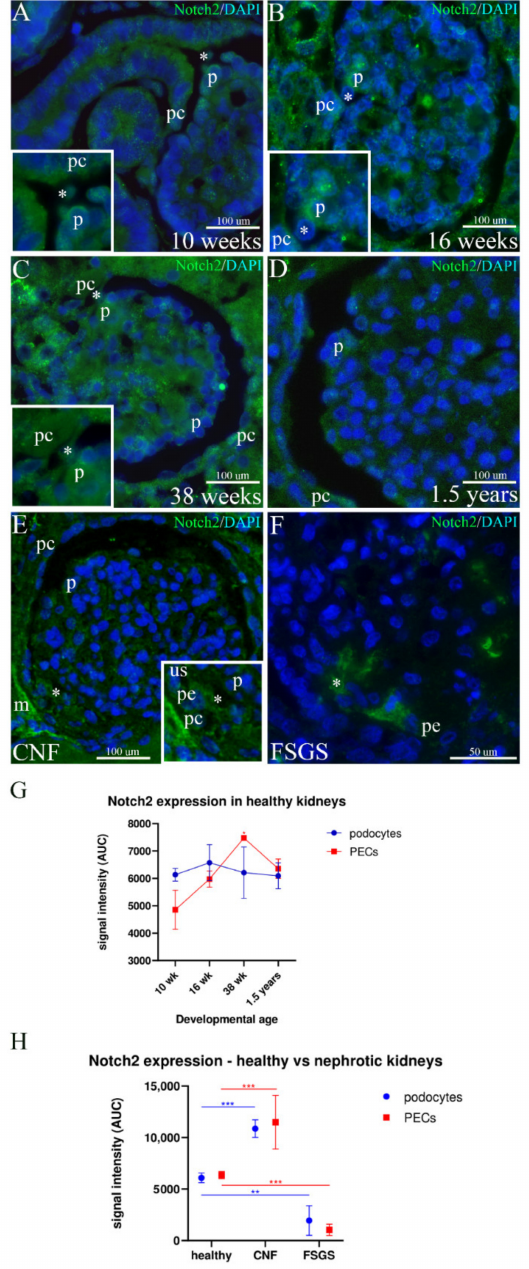
Figure 4. Expression of Notch2 in the developing podocytes and PECs in postnatal healthy kidneys and in kidneys affected by CNF and FSGS; mesenchyme (m), podocytes (p), PECs (pc), peripolar cells (pe), urinary space (us). ( A ) 10th developmental week; cells bridging the urinary space are seen (inset, asterisk). ( B ) 16th developmental week; cellular bridges (asterisk) connect podocytes and PECs (inset). ( C ) 38th developmental week; cellular processes (asterisk) span the urinary space (inset). ( D ) Postnatal healthy kidneys; moderate Notch2 expression is seen in podocytes and PECs. ( E ) CNF kidneys; peripolar cells (asterisk, inset) bridging the urinary space show moderate Notch2 expression. ( F ) FSGS kidneys; strong expression of Notch2 (asterisk) is seen in some glomerular cells, and only occasionally in the peripolar cells. ( G ) Overall expression pattern of Notch2 in healthy developing kidneys. ( H ) The comparison of the expression pattern between healthy and nephrotic kidneys shows significant differences in both podocyte and PEC subpopulations. Error bars show SD. * p < 0.05; ** p < 0.01; *** p <